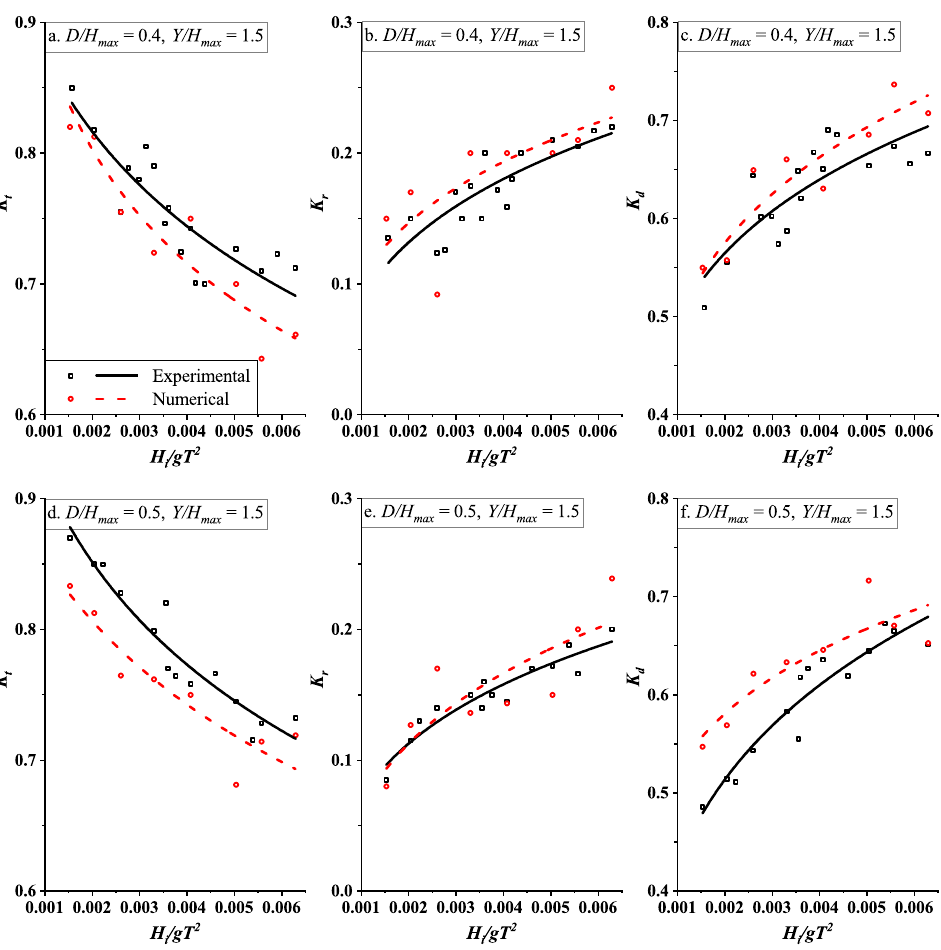
Figure 8. Comparison of numerical and experimental results for various D/H max of non-perforated CPHBs. ( a ) K t for D/H max = 0.4 and Y/H max = 1.5, ( b ) K r for D/H max = 0.4 and Y/H max = 1.5, ( c ) K d for D/H max = 0.4 and Y/H max = 1.5, ( d ) K t for D/H max = 0.5 and Y/H max = 1.5, ( e ) K r for D/H max = 0.5 and Y/H max = 1.5, ( f ) K d for D/H max = 0.5 and Y/H max =